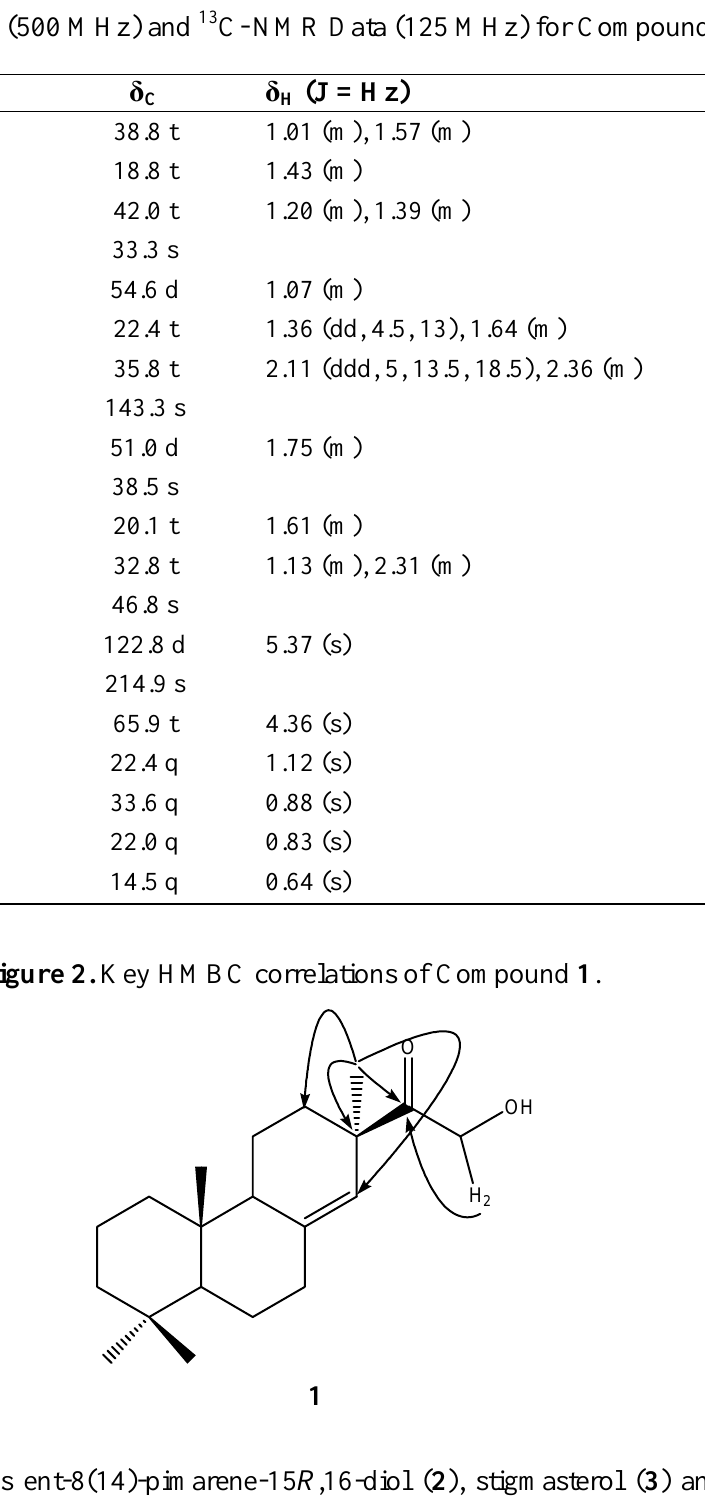
Table 1. 1 H-NMR Data (500 MHz) and 13 C- NMR Data (125 MHz) for Compound 1 (CDCl